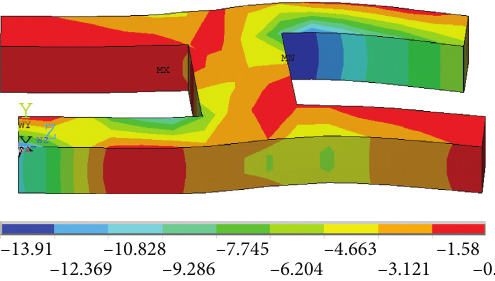
Figure 29: The third principal stress